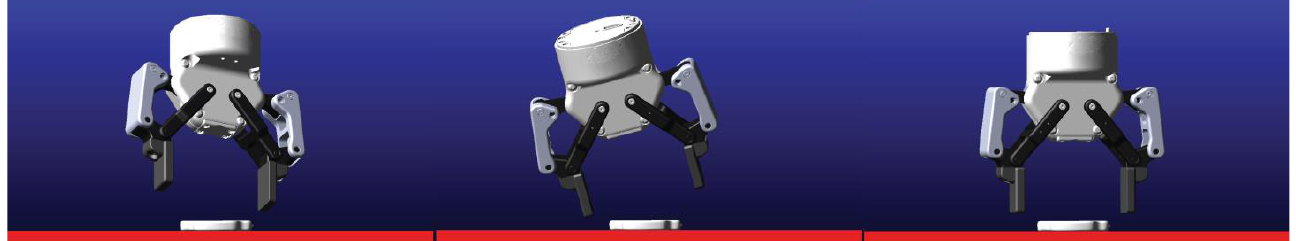
Figure 3. Model of robotic gripper and the object to be gripped in ADAMS/View with different rotation settings. Source: Own. rotation settings. Source: